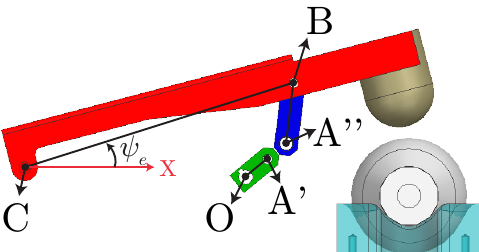
Figure 6. The combination of design parameters | OA | , | AB | , and | BC | serves as an infeasible design that cannot be assembled in ψ e